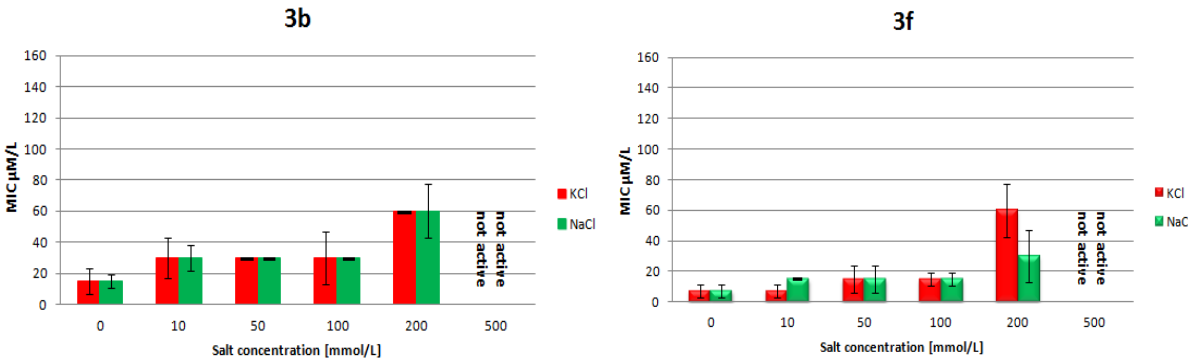
Figure 2. The effect of monovalent cations, Na + or K + on the MICs of 3b and 3f against E. coli ATCC 25922 (black bars represent mean